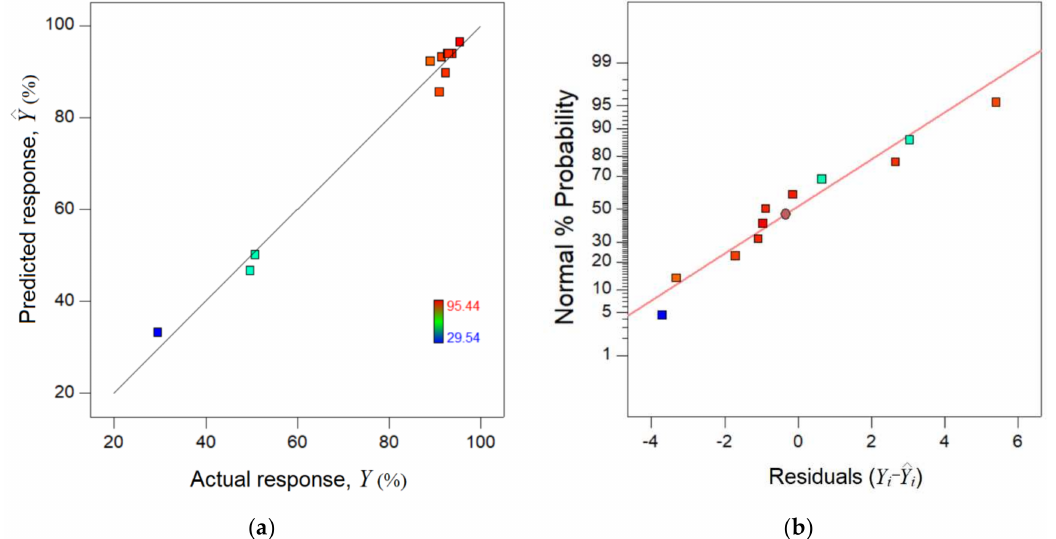
Figure 9. Agreement between experimental data and model predictions: ( a ) parity plot and ( b ) normal plot of